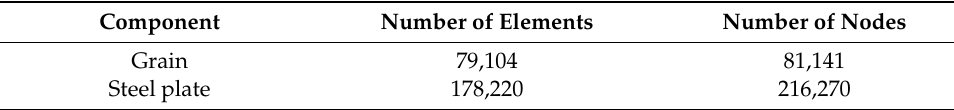
Figure 1. Meshed collision model. Table 1. Comparison of grid models between the grain and steel plate.